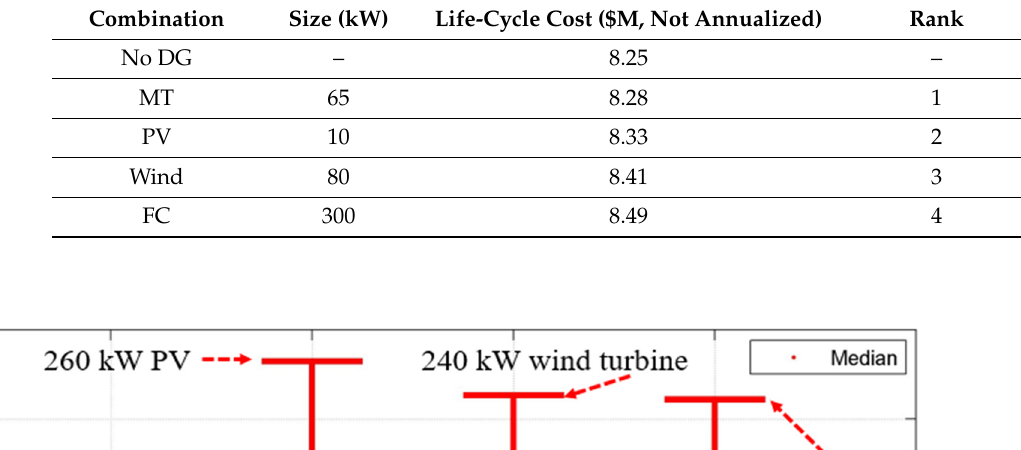
Table 3. Most cost-efficient DG without AbCs.